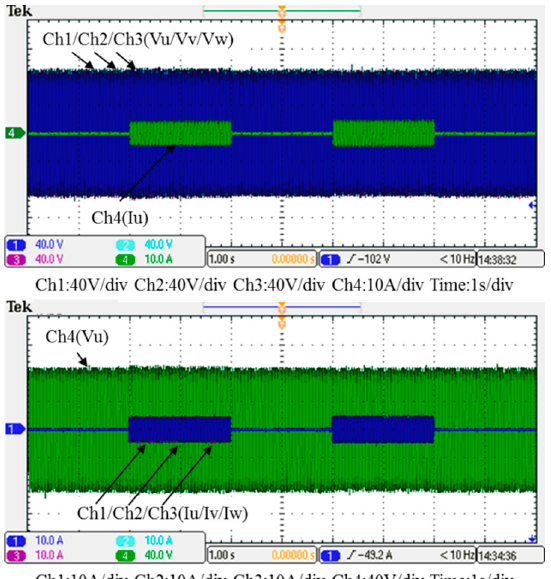
Figure 30. Case 2 implementation result: three-phase voltages and currents.